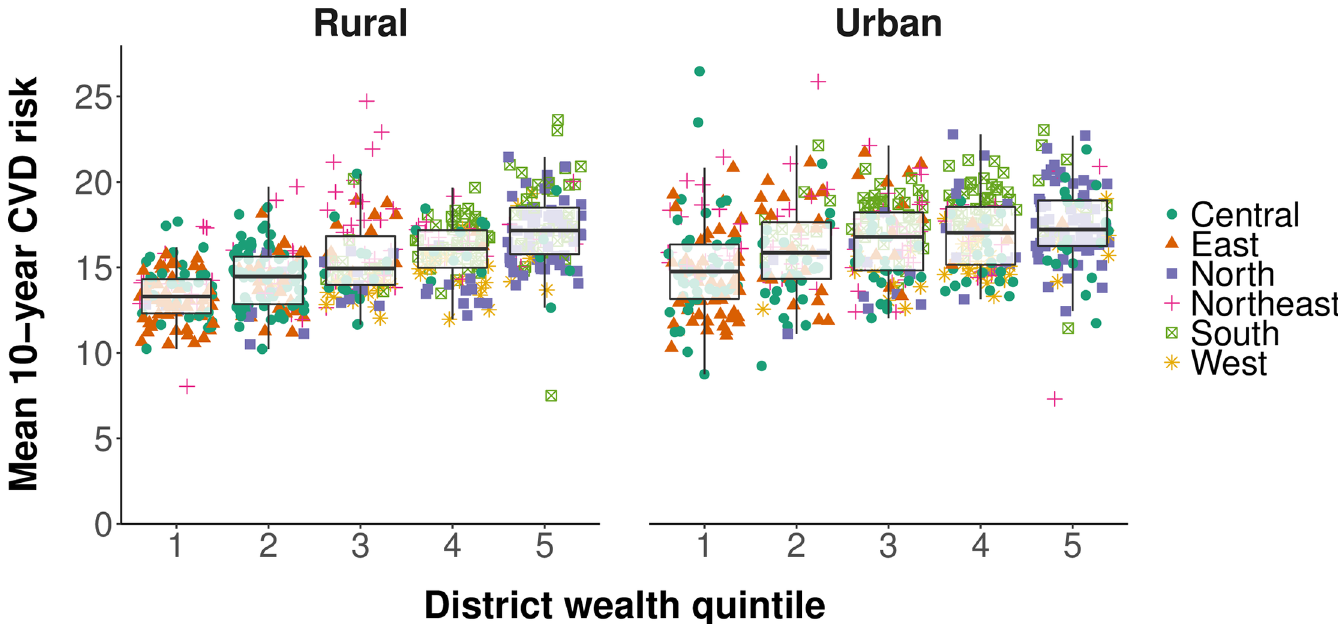
Fig 5. Association between the age-standardized district-level mean 10-year cardiovascular disease risk and district wealth quintile. Mean 10-year risk of a cardiovascular disease (CVD) event was calculated using the Framingham risk score. District wealth quintile was calculated, separately for rural and urban areas within districts, by computing the median of the continuous household wealth index in a district and then categorizing the district-level median into quintiles. Age standardization was to the Global Burden of Disease project’s 2013 population structure for India [36]. The sample in each district was restricted to those aged 30 to 74 years. States and districts were divided into regions as per their allocation to Zonal Councils by the Government of India [39]. The whiskers of the box and whisker diagrams end at 1.5 × interquartile range.